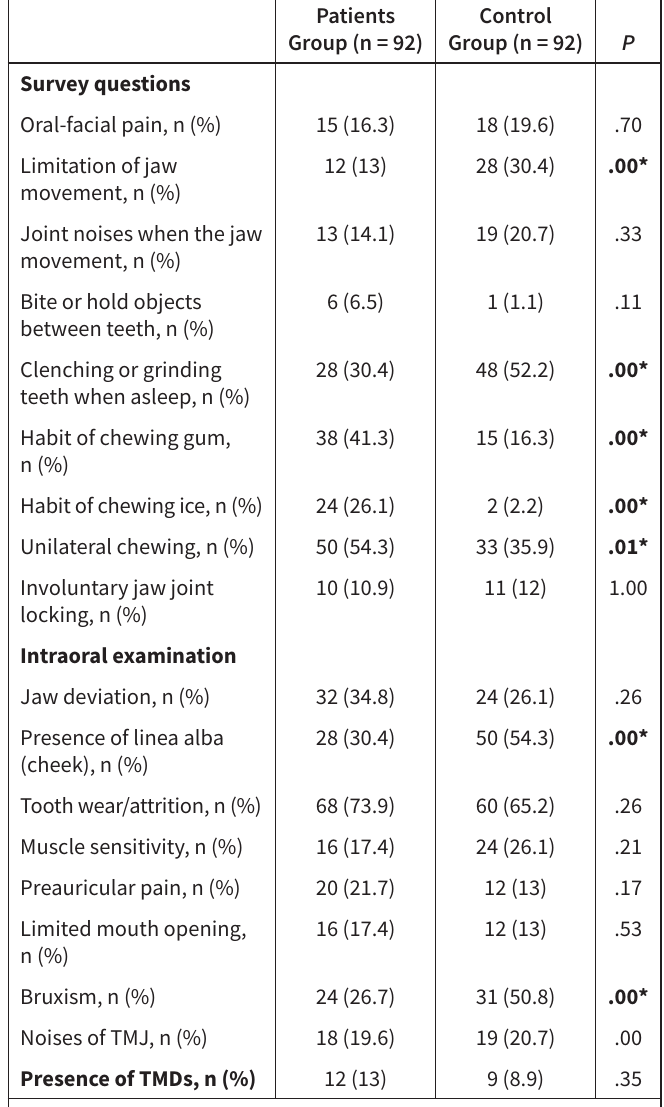
Table 2. Comparison of Baseline Characteristics of Participants Between Patients and Control Group